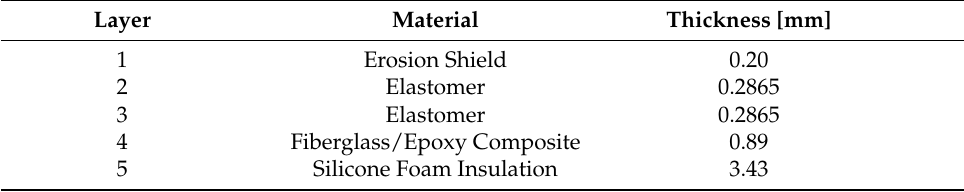
Table 3. Thickness and composition of the multilayered stack.